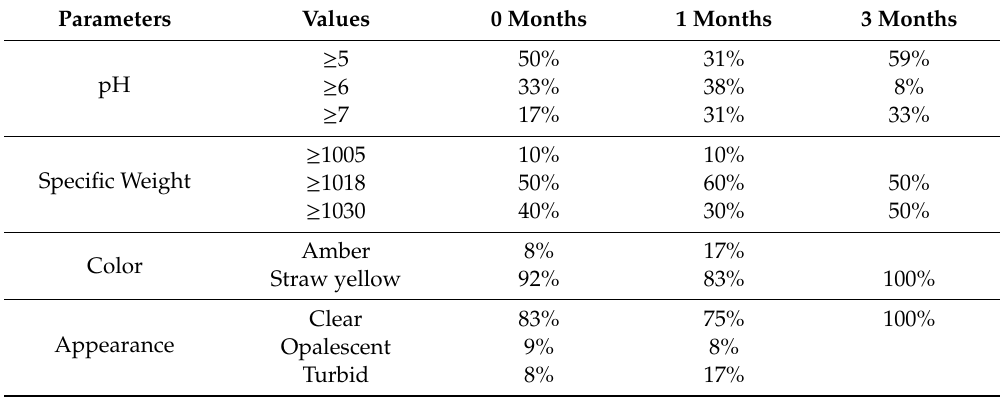
Figure 1. Hydration status. ( A ) Assessment of urine pH at 0, 1, and 3 months in a group of 12 professional basketball athletes. The data are expressed as the mean ± SD. The significance was determined by the one-way ANOVA test: ** ( p < 0.01) represents significance compared with 0 months; ### ( p < 0.001) represents significance compared with 1 month. ( B ) assessment of specific weight at 0, 1, and 3 months in a group of 12 professional basketball athletes. The data are expressed as the mean ± SD. The significance was determined by the one-way ANOVA test *** ( p < 0.001) represents significance compared with 0 months. Table 1. Hydration parameters. Percentage representation of pH, specific weight, color and appearance of urine in a group of 12 professional athletes .